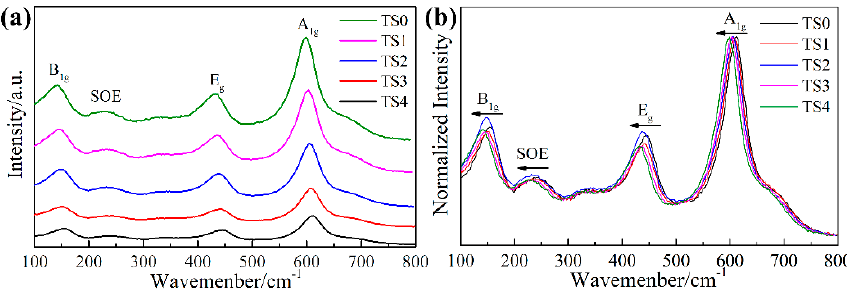
Figure 2. ( a ) Raman patterns of pure TiO2 NWAs (TS0) and Sn-doped TiO2 NWAs (TS1, TS2, TS3, TS4); ( b ) normalized Raman patterns of pure TiO2 NWAs (TS0) and Sn-doped TiO2 NWAs (TS1, TS2, TS3, TS4).